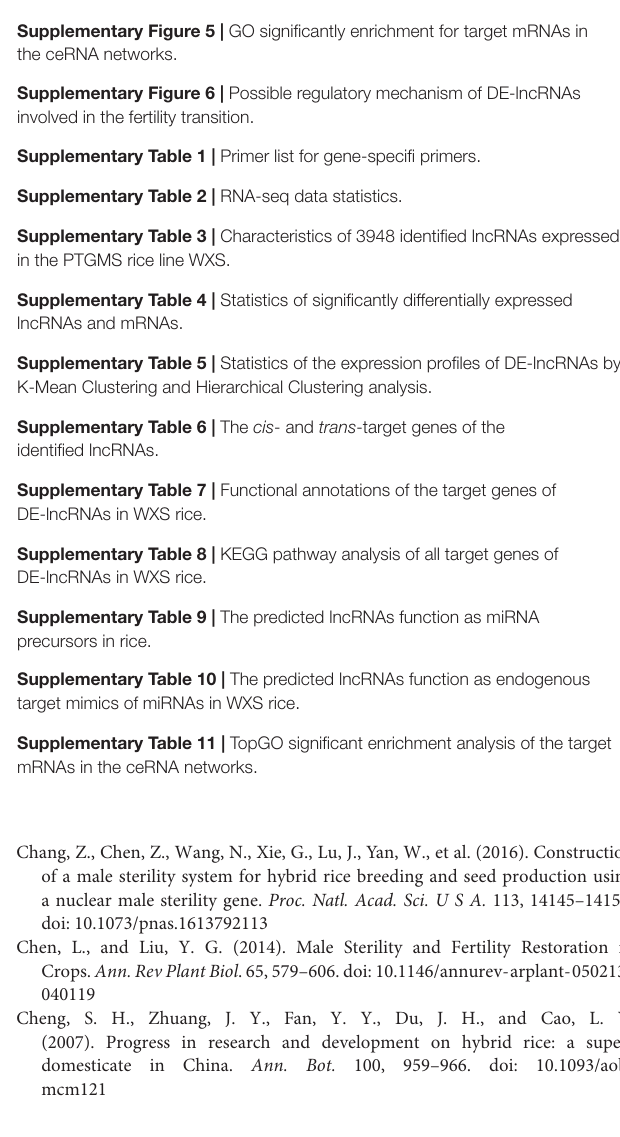
Supplementary Figure 1 | The diagram of the correlation of biological replications using the Pearson’s Correlation Coefficient. Supplementary Figure 2 | Genome-wide gene expression profiles of all DE-lncRNAs in WXS-S rice. (A) The Hierarchical clustering of the DE-lncRNAs in different developmental stages of WXS-S. (B) Heat map of DE-lncRNAs by the K-means clustering method. Supplementary Figure 3 | Genome-wide gene expression profiles of all DE-lncRNAs in WXS-F rice. (A) The Hierarchical clustering of the DE-lncRNAs in different developmental stages of WXS-F. (B) Heat map of DE-lncRNAs by the K-means clustering method. Supplementary Figure 4 | Interaction networks between lncRNAs and mRNAs in the PTGMS rice line. Supplementary Figure 5 | GO significantly enrichment for target mRNAs in the ceRNA networks. Supplementary Figure 6 | Possible regulatory mechanism of DE-lncRNAs involved in the fertility transition. Supplementary Table 1 | Primer list for gene-specifi primers. Supplementary Table 2 | RNA-seq data statistics.